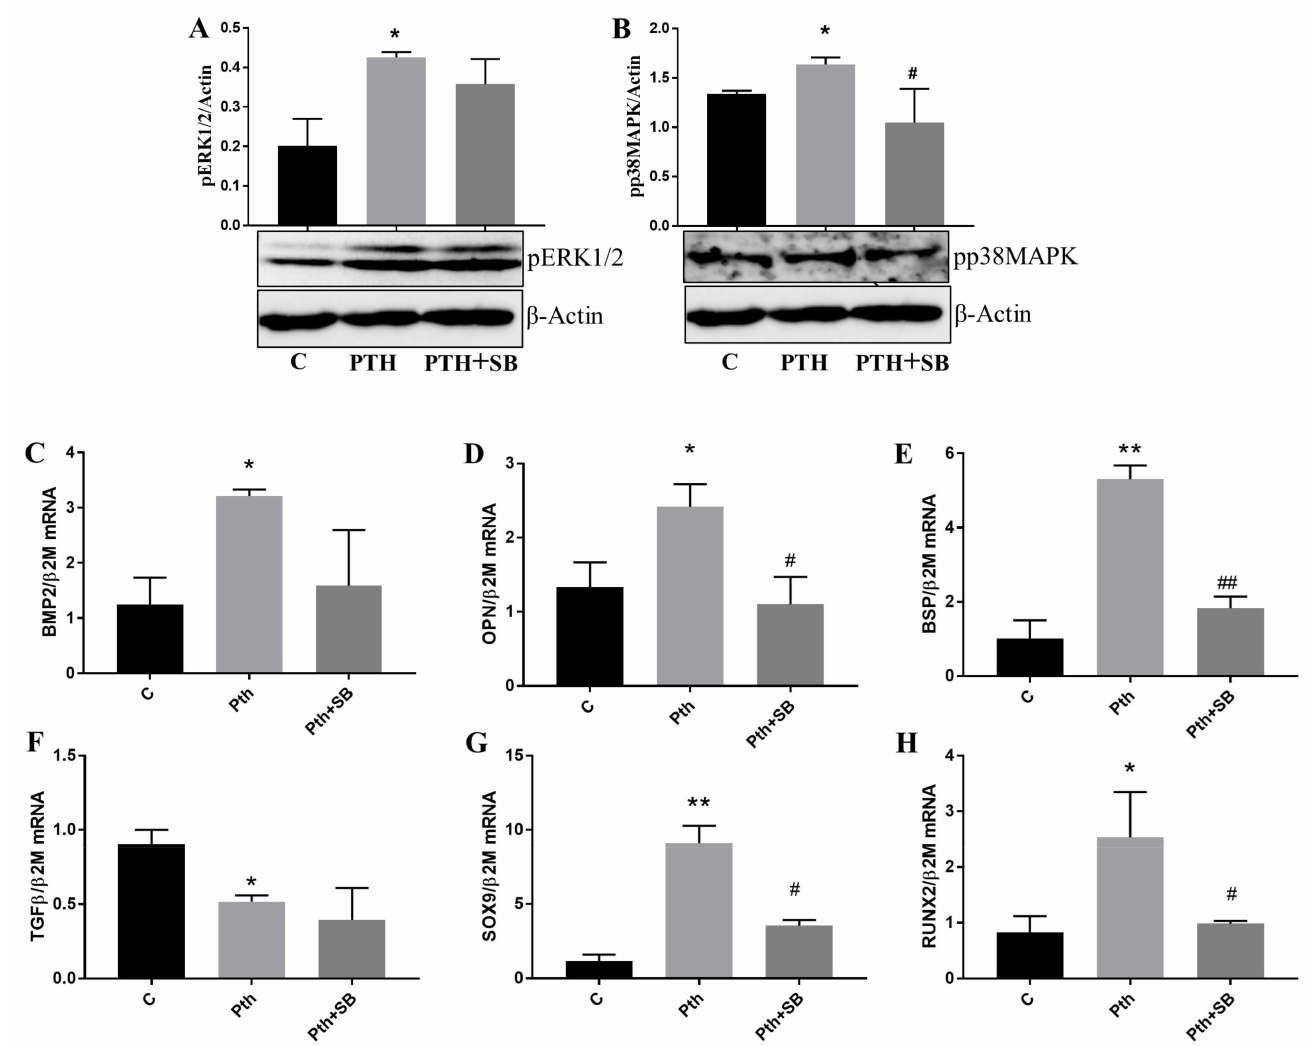
Figure 5. PTH activates MAPK signaling pathways and induces gene expression of osteogenic molecules in VEC. ( A , B ) The effect of PTH on the expression of phosphorylated ERK1/2 ( A ) and p38MAPK ( B ) in valvular endothelial cells. Cell lysates from control—C or PTH-treated VEC -PTH, cultured for 7 days in the presence or absence of SB-239063, were analyzed by western blot. ( C – H ) Gene expression of osteogenic molecules BMP2 ( C ), OPN ( D ), BSP ( E ), TGF- β 1 ( F ), SOX-9 ( G ) and RUNX-2 ( H ) expressed by human VEC exposed to PTH in the presence or absence of p38MAPK inhibitor SB239063 for 7 days, as evaluated by qPCR. The mRNA of osteogenic molecules was normal- ized to β 2 -Microglobulin ( β 2M) mRNA. n = 3, * p < 0.05, ** p < 0.01 (PTH vs. C); # p < 0.05, ## p < 0.01 (PTH+SB vs.